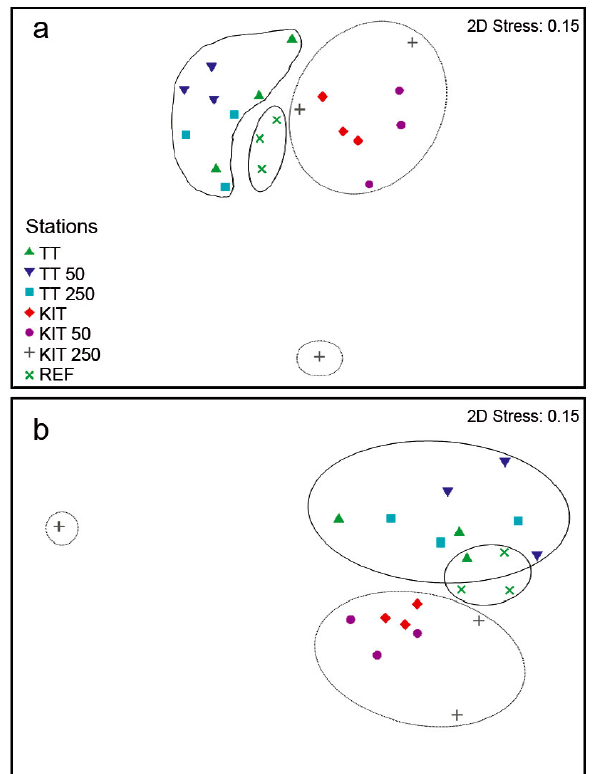
Fig. 2. Non-metric multidimensional scaling ordination plots of species abundance in macrobenthic samples sieved through different mesh sizes: (a) ‘total sieve’ (i.e. results from 1 and 0.5 mm sieves combined) and (b) 1 mm sieve. See Table 1 for details on sampling stations. Data were square- root transformed. Resemblance: S17 Bray-Curtis